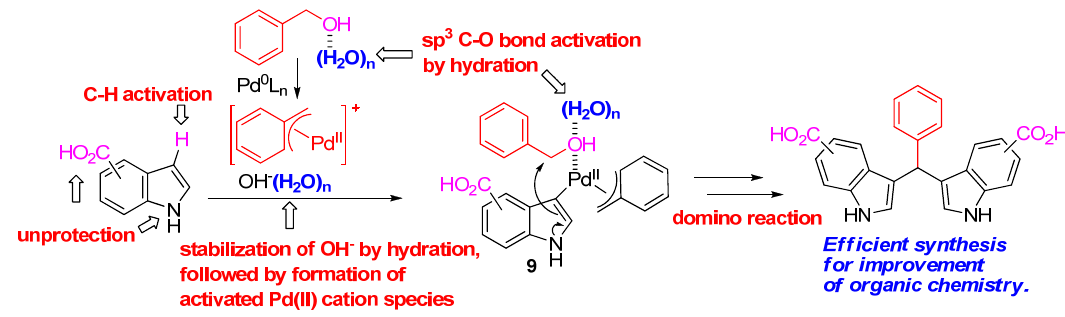
Scheme 7. Development of unprotected syntheses, new activated catalysts, and new reaction